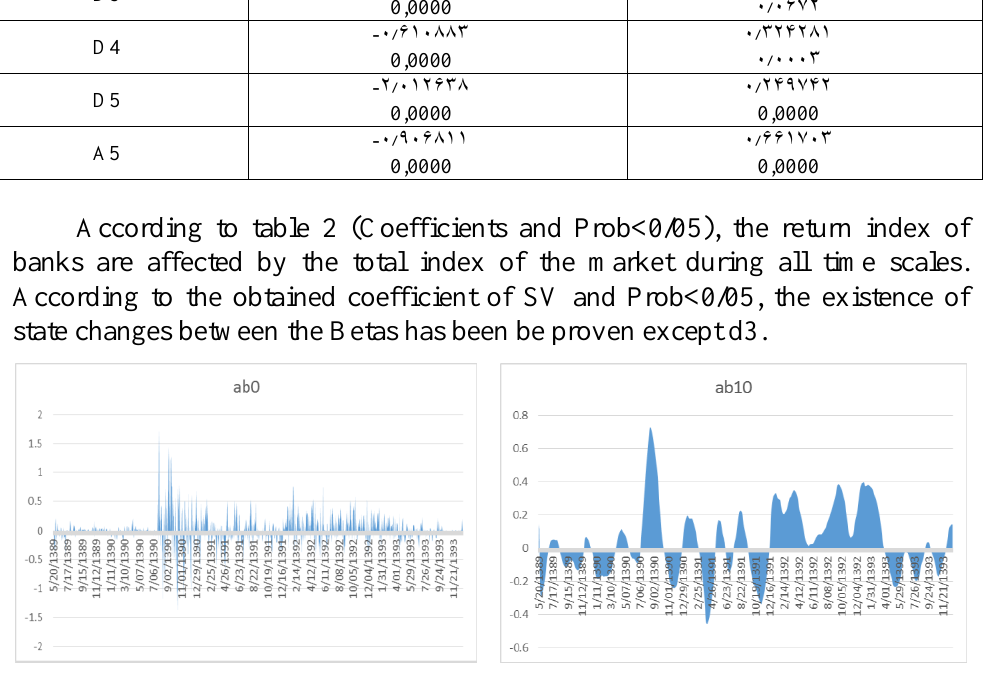
Figure 4. original series and long-term series of Beta of